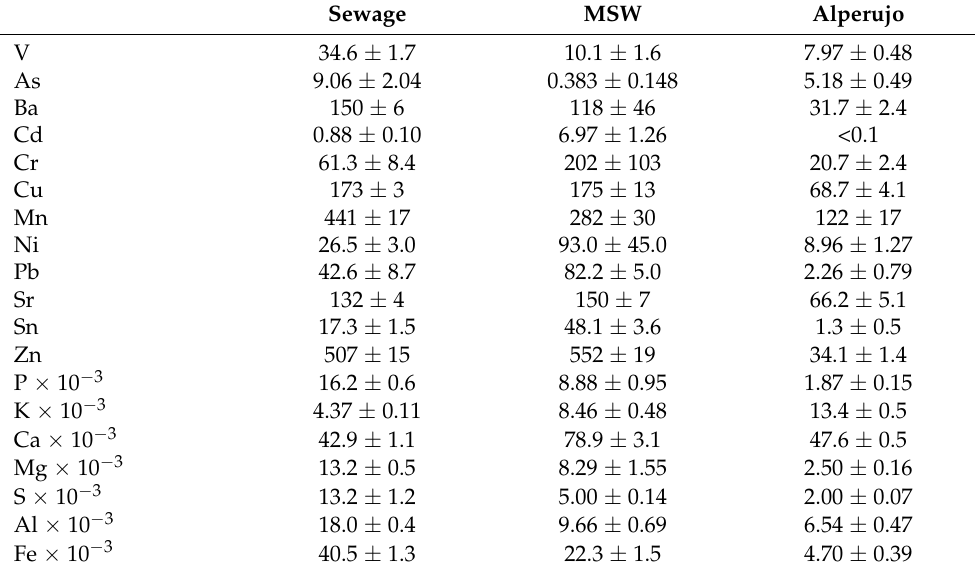
Table 2. Extractable aqua regia contents of the composts (mg kg − 1 ± standard deviation). Sewage MSW